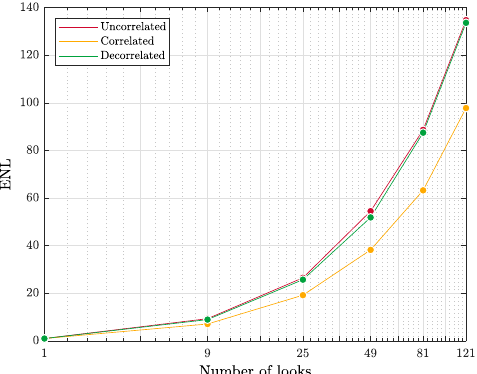
Figure 6. Estimated equivalent number of looks (ENL) as a function of increasing local window